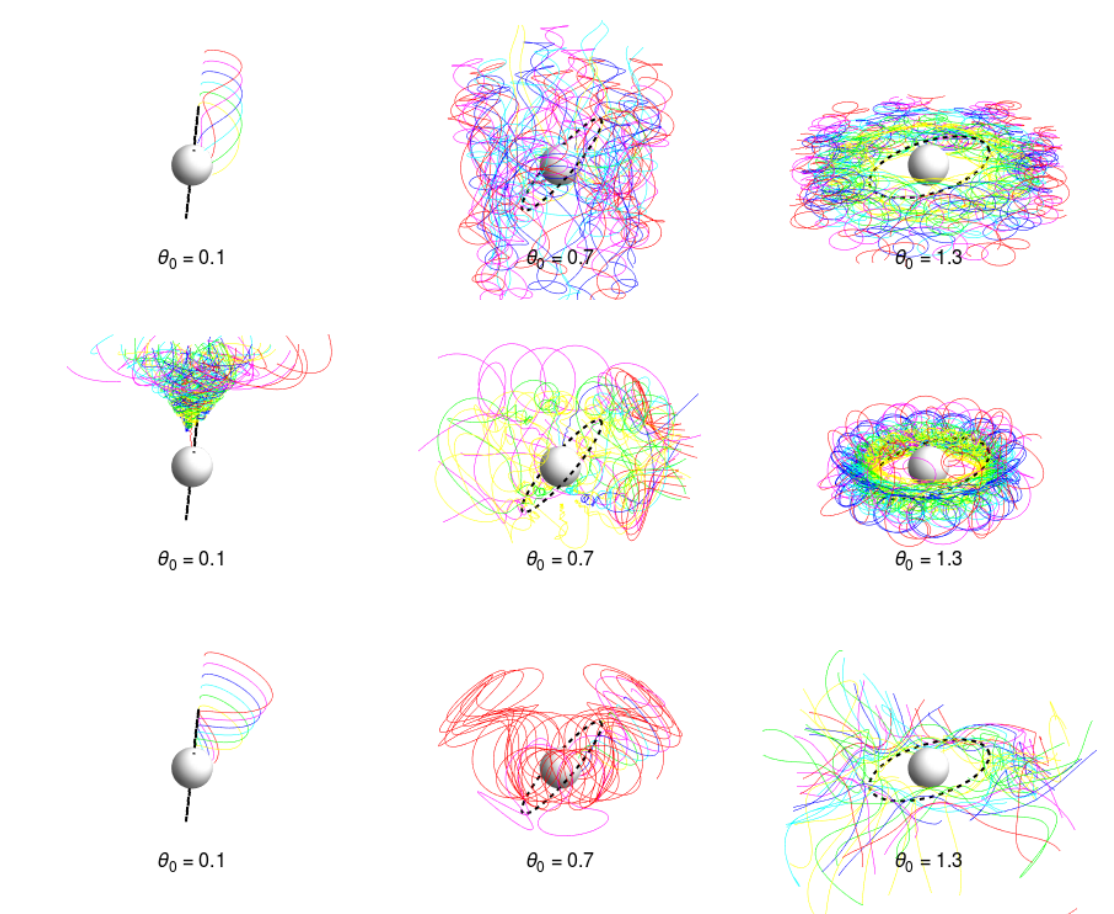
Figure 9. Thin Keplerian accretion disk around Schwarzschild BH in uniform (fist row), dipole (second row) and parabolic (third row) magnetic field. Magnetic field parameter is the same in all cases B = 0.1, while the disk inclination θ 0 is